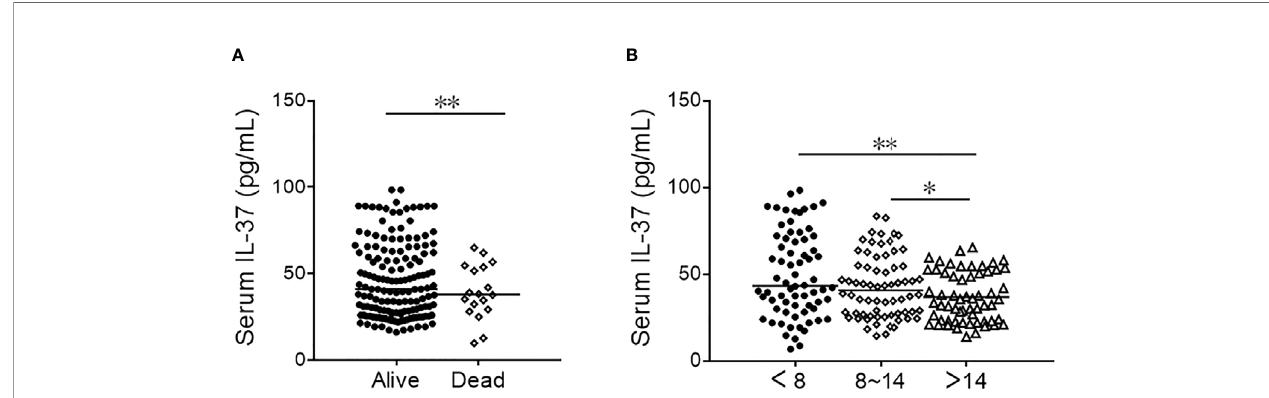
FIGURE 3 | The levels of serum IL-37 in alive and dead CAP patients. (A, B) The level of serum IL-37 was detected with ELISA. (A) The level of serum IL-37 in alive and dead CAP patients. (B) The level of serum IL-37 in different hospital stay of CAP patients. * P < 0.05, ** P < 0.01.